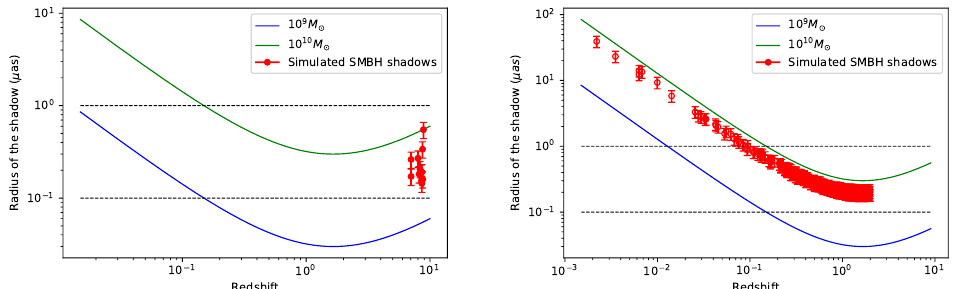
Figure 3. Left : Simulations for 10 SMBH shadows at high(er) redshift in 7 ≤ z ≤ 9, with 10 9 − 10 10 M (cid:12) . We consider a fiducial conservative cosmology with H 0 = 73.8 km/s/Mpc, Ω m 0 = 0.262. Dashed lines indicate the values α sh = 0.1 µ as and α sh = 1 µ as, from bottom to top respectively. Right : Simulations for 500 SMBH shadows at low redshift in 0.0001 ≤ z ≤ 2.5, with 5 × 10 9 M (cid:12) . We consider the same latter cosmology setup. Dashed lines indicate the values α sh = 0.1 µ as and α sh = 1 µ as, from bottom to top,